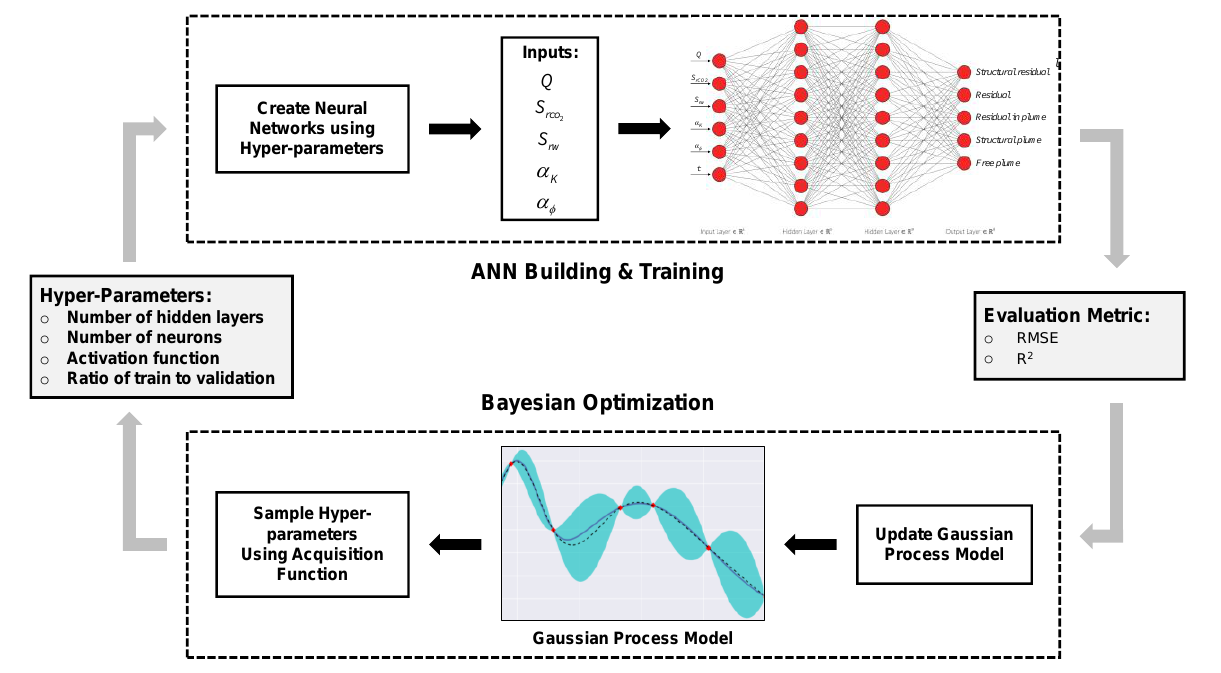
Figure 5. The process of ANN training with Bayesian optimization.